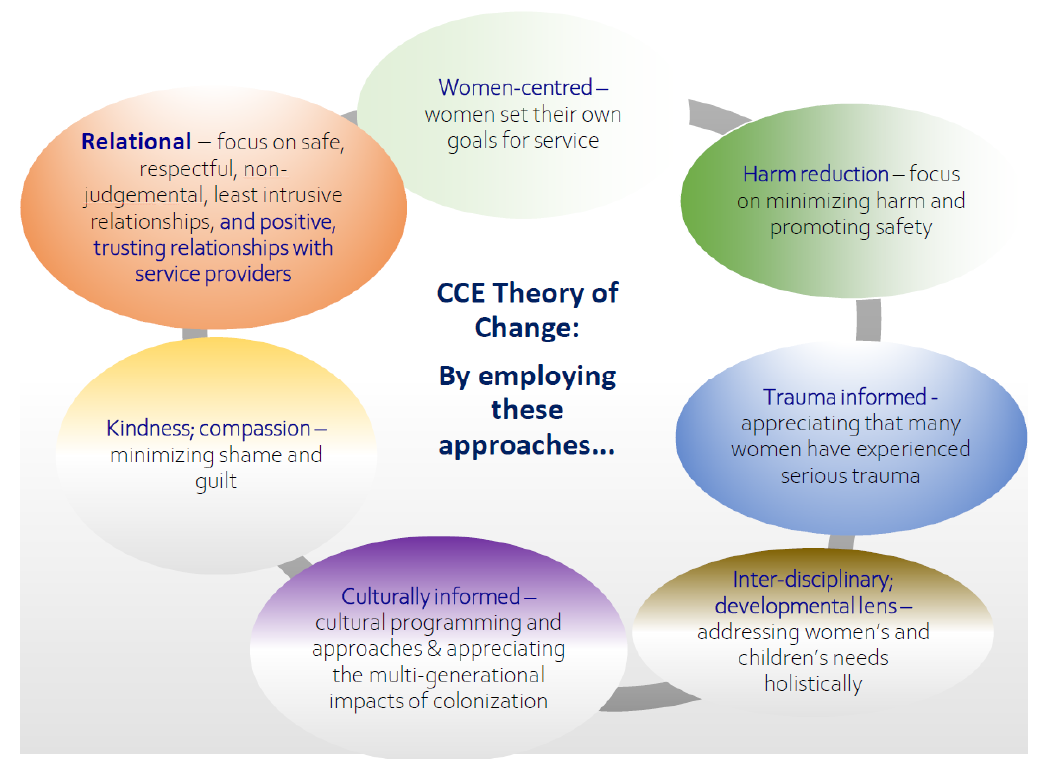
Figure 2. Key philosophy / approaches of programs involved in the Co-Creating Evidence: National Evaluation of Multi-Service Programs Reaching Women at Risk (CCE) project.